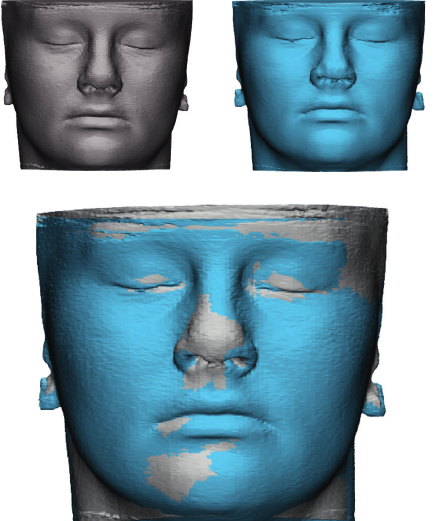
Figure 3: Example of surface-based superimposition of CBCT-derived patient’s facial soft tissues before and after orthodontic treatment with maxillary expander.